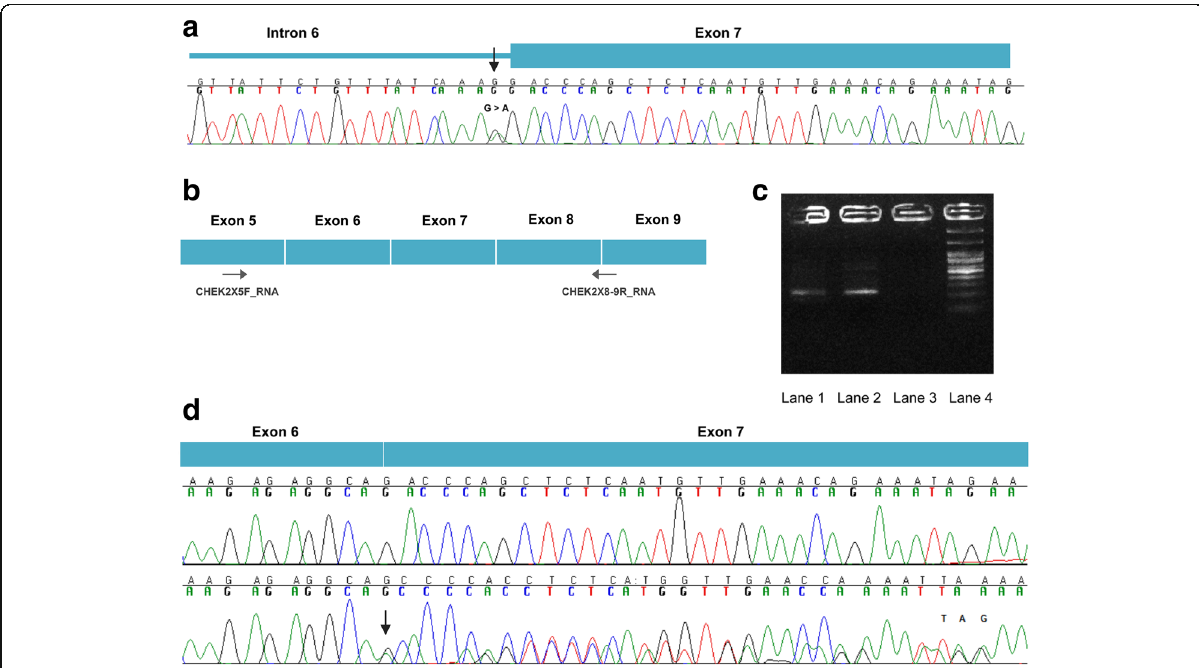
Fig. 2 a Sequencing analysis of genomic DNA from the proband carrying the c.793-1G> A variant in the CHEK2 gene. b Binding sites of the primers on the cDNA of CHEK2 c RT-PCR electrophoresis products on 3% agarose gel. Lane 1: proband ’ s sample with the splicing variant, Lane 2: normal sample, Lane 3: negative control, Lane 4: 1000 bp DNA ladder (New England Biolabs). d Sequencing analysis of the proband ’ s cDNA showing the frameshift of the variant and the generation of a premature translation stop signal (TAG) 10 amino acid residues later (bottom panel) compared to the sequencing analysis of a wild type sample (top